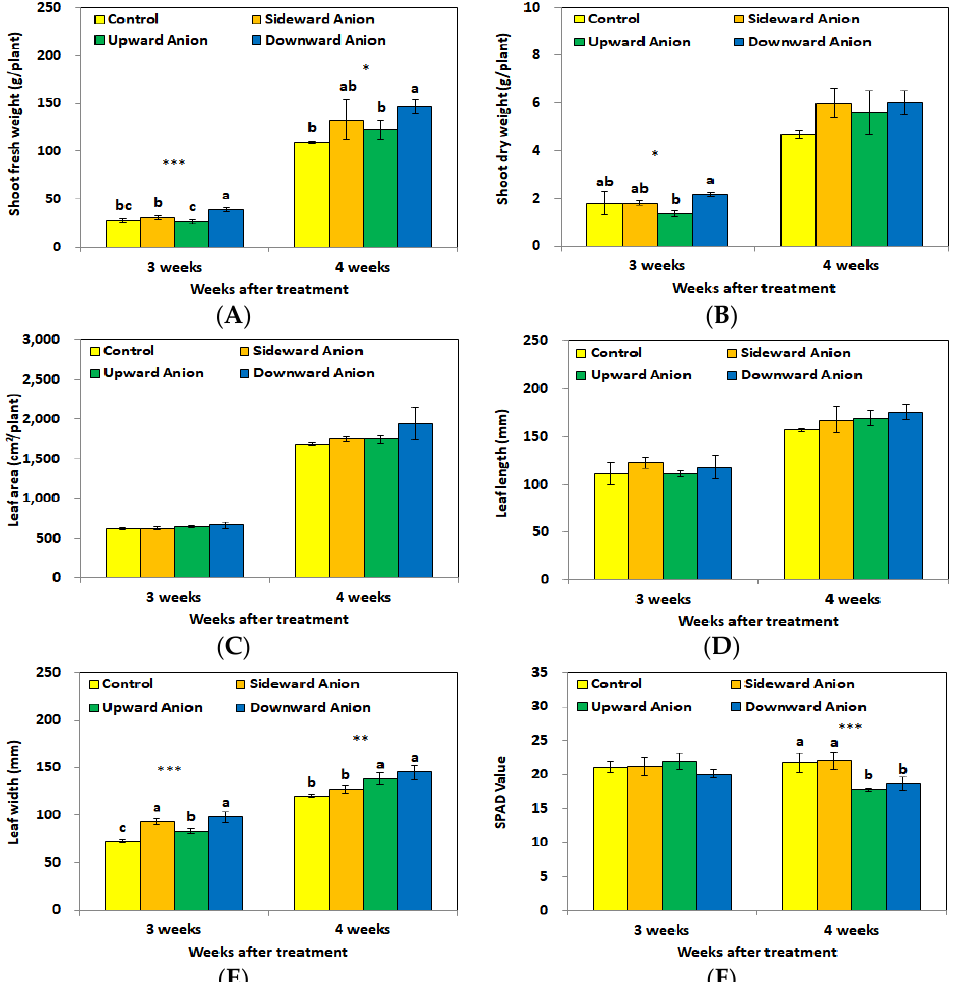
Figure 3. Comparison of the growth characteristics of lettuce relative to air anion generation position: ( A ) FW, ( B ) DW, ( C ) LA, ( D ) LL, ( E ) LW, and ( F ) SPAD. Values are mean ± standard error ( n = 3). *, **, and ** indicate that correlations are significant at the 0.05, 0.01, and 0.001 probability levels, respectively.